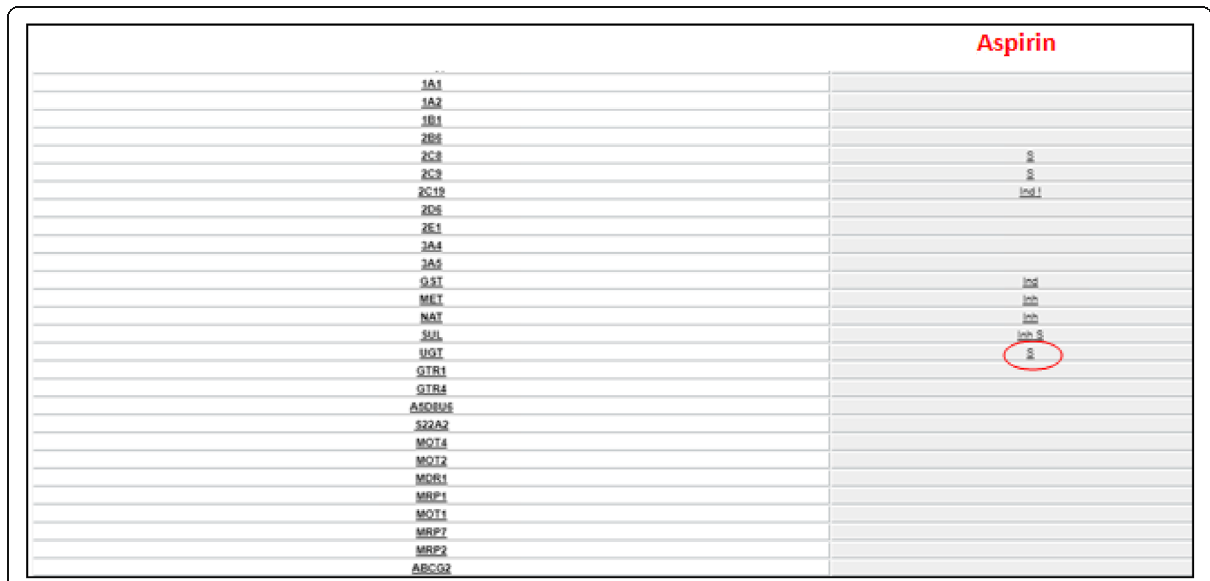
Fig. 3 Aspirin metabolic profile. In the left column there is the list of drug metabolizing enzymes and drug transporters, one for each row; in the right column relationship between corresponding transporter or enzyme of the row and aspirin: is indicated by the symbol ‘ S ’ for substrate, ‘ Inh ’ for inhibitor and ‘ Ind ’ for inducer. Enzyme UGT is rimmed to emphasize their importance in aspirin ’ s metabolic destiny. Related page at the website